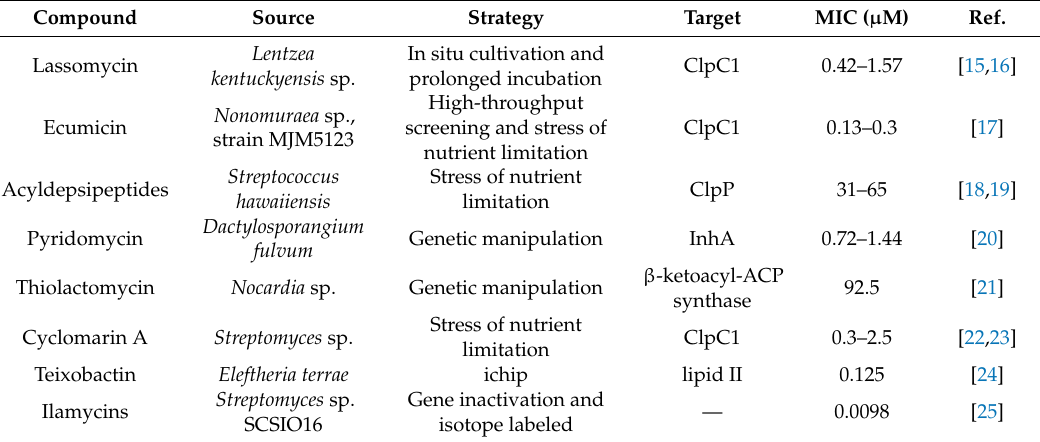
Table 4. Source, activity, and target of anti-TB natural